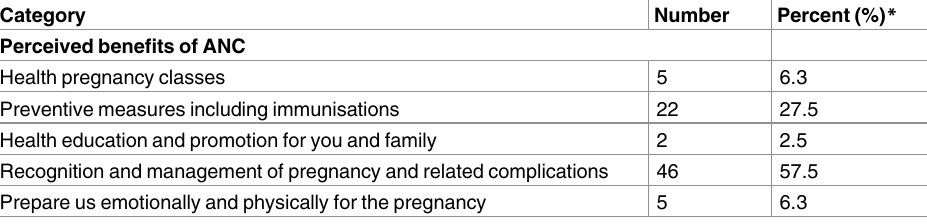
Table 3. Perceived benefits to ANC utilisation by all expectant